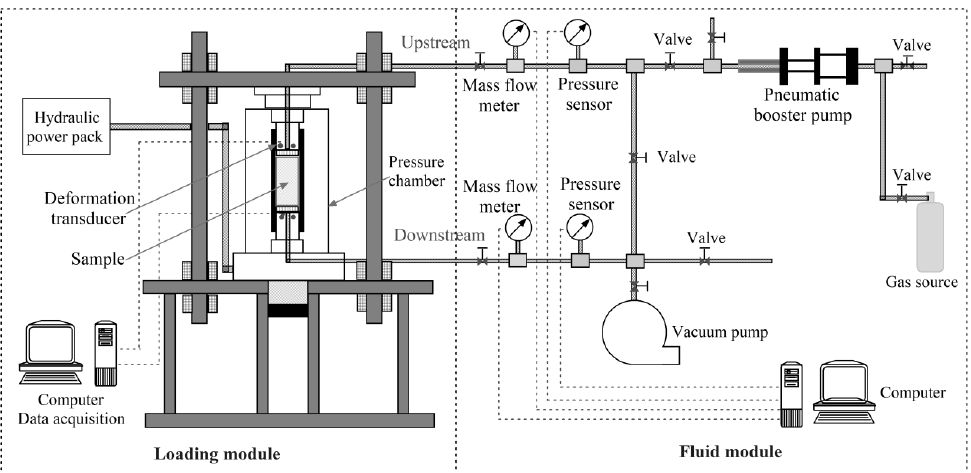
Figure 2. Schematic of the experimental system.